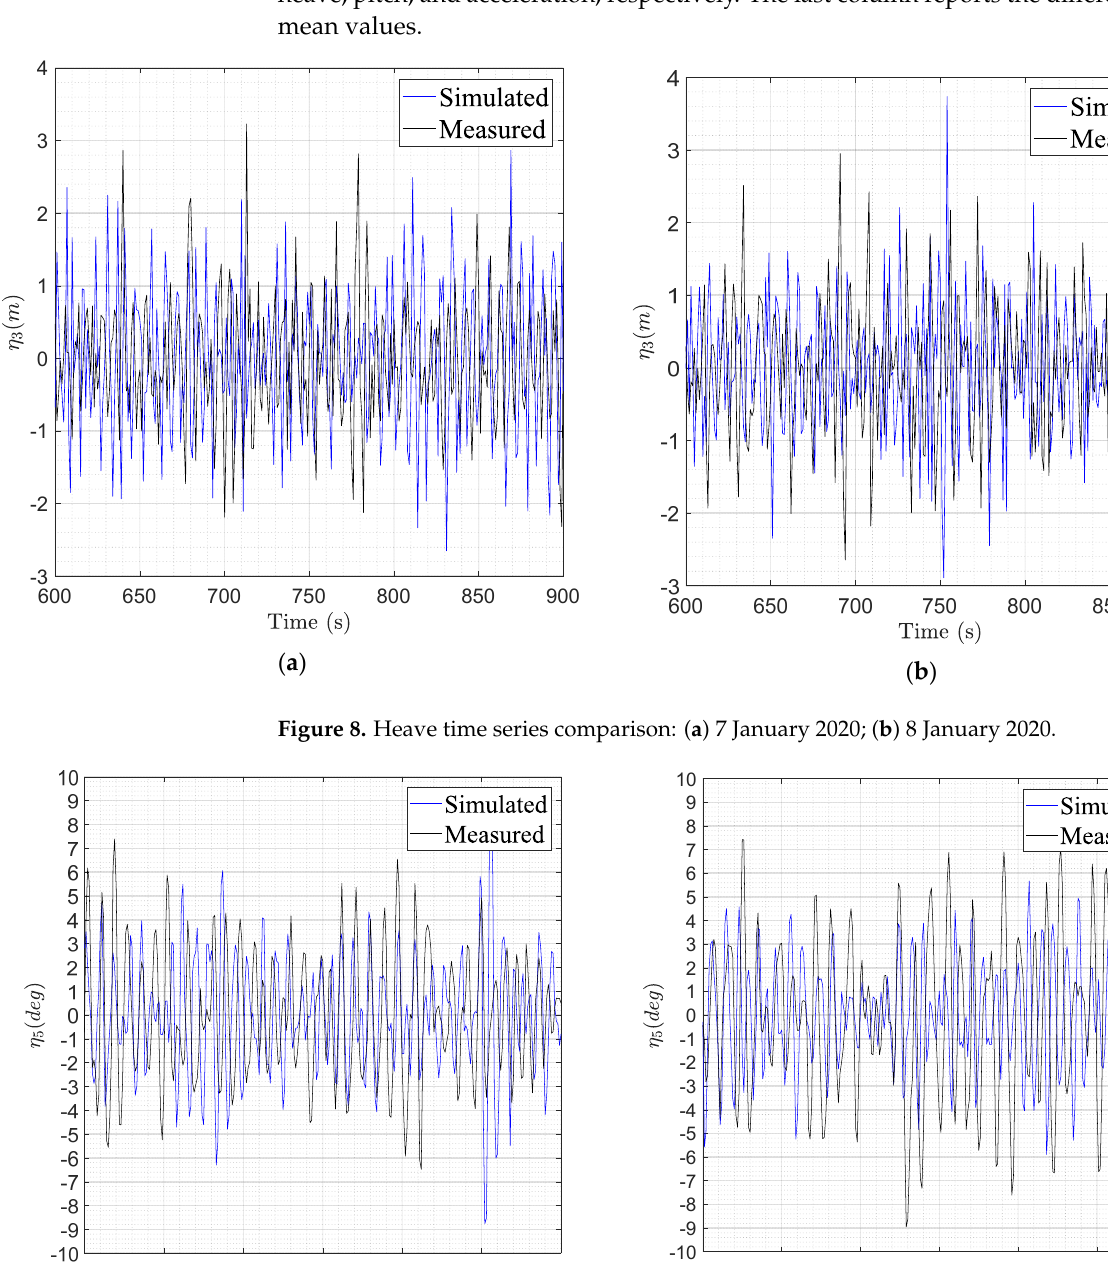
( b ) Figure 10. Acceleration time series comparison: ( a ) 7 January 2020; ( b ) 8 January 2020. Table 4. Results comparison for heave motion . Simulated